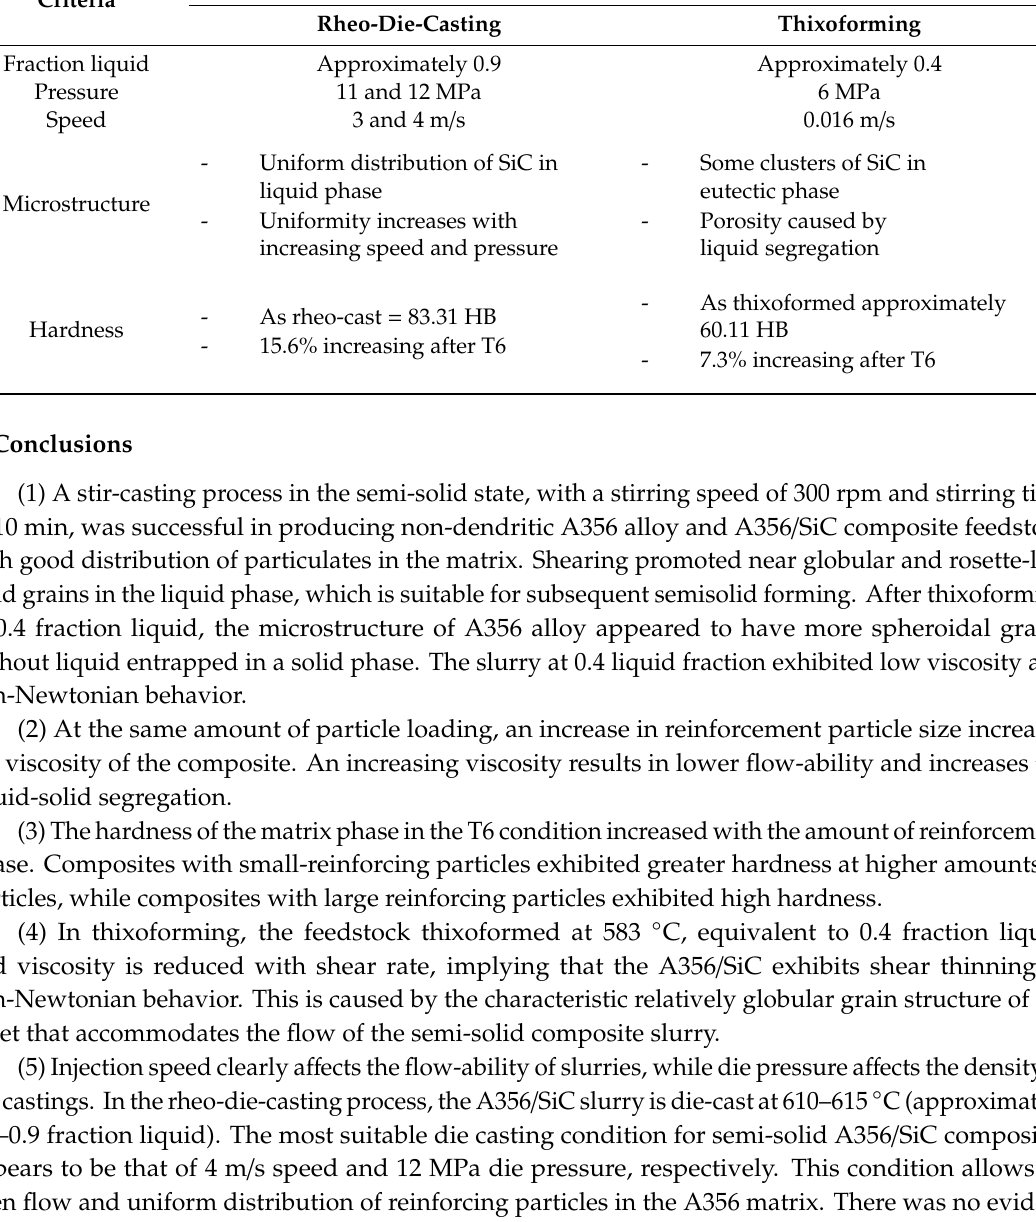
Table 2. Comparison of thixoforming and rheo-die casting of A356 / SiC (15%SiC-15 µ m). Criteria Fraction